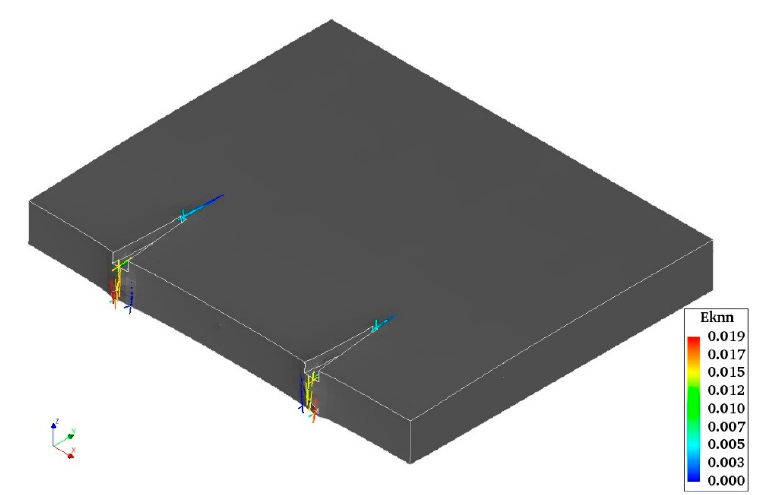
Figure 19. Crack initiation in ARCP-2 from the saw-cuts.